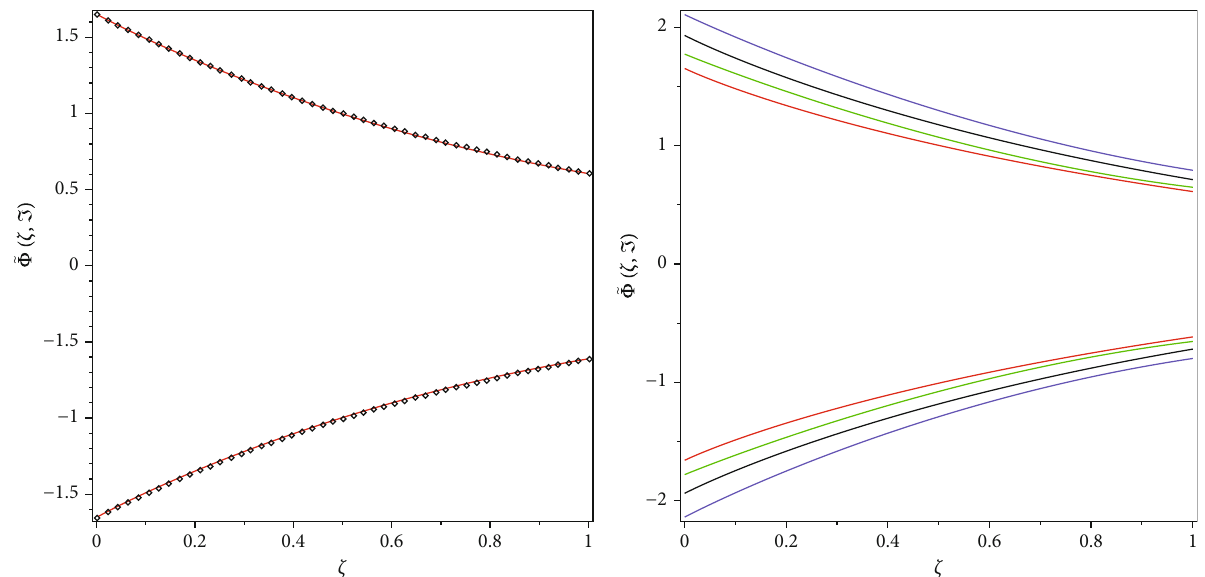
Figure 3 indicates how the e ffi ciency of various (upper and lower bound accuracy) surface plots for example 1 con- nect with the fuzzy Atangana-Baleanu operator and Shehu transformation is being shown in this research. Figure 4 shows that the lower and upper bounded graph of two dimensional. The pattern identi fi es the fl uctuation in the ~ Φ ð ζ , I Þ on the space coordinate ξ with the consid- mapping ering of I and the uncertainty parameter r ε ½ 0, 1 (cid:2) . The fi gure ~ Φ ð ζ , I Þ will become shows that, as time passes, the mapping more intricate.